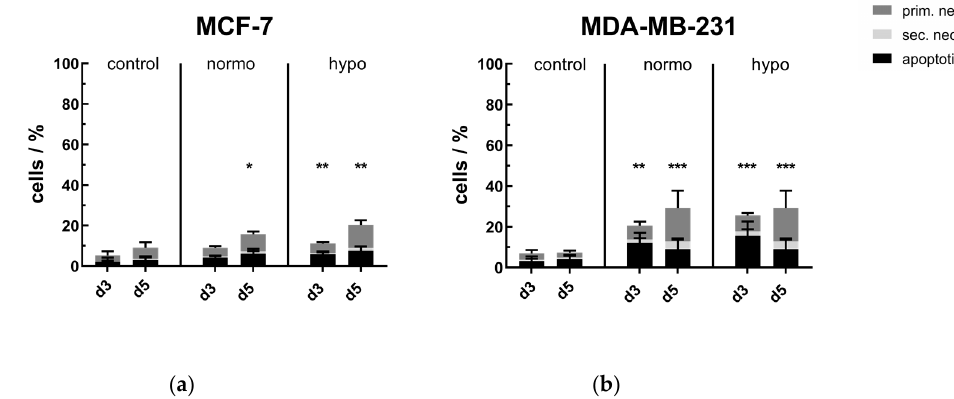
Figure 1. Cell death forms of ( a ) MCF-7 and ( b ) MDA-MB-231 breast cancer cells after normo- and hypofractionated radiotherapy. Cell death forms were analyzed by AxV/PI-staining and multicolor flow cytometry measurement. AxV + /PI - cells are apoptotic ones, AxV + /PI ++ cells are primary and AxV + /PI + are secondary necrotic ones. The total percentage of dead cells yields the tumor cell killing efficiency. Mean ± S.D. are presented from at least four independent experiments, each measured in duplicates. Significance test was conducted using Kruskal-Wallis test with uncorrected Dunn’s multiple comparison, by comparing the treatment-related total percentages of killed cells to the corresponding controls of mock-treated cells at the indicated time points (d3,d5); * ( p < 0.1), ** ( p < 0.01), *** ( p < 0.001).